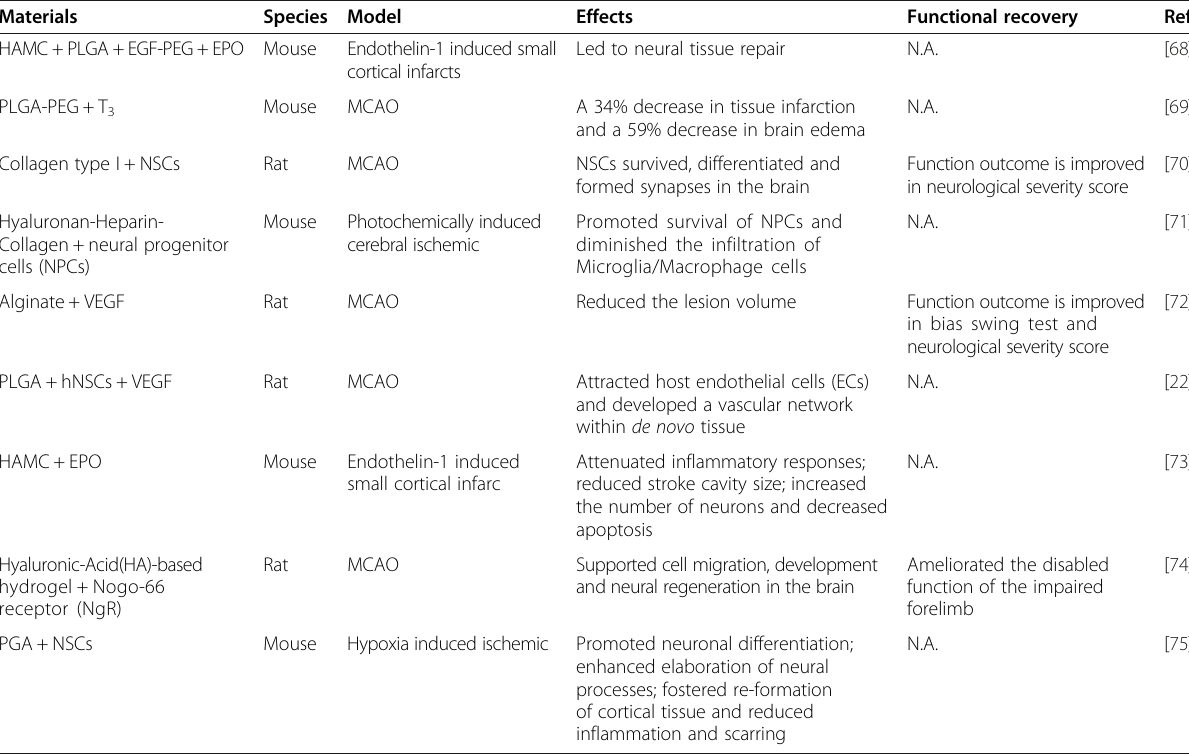
Table 2 Biomaterials used in the treatment of stroke